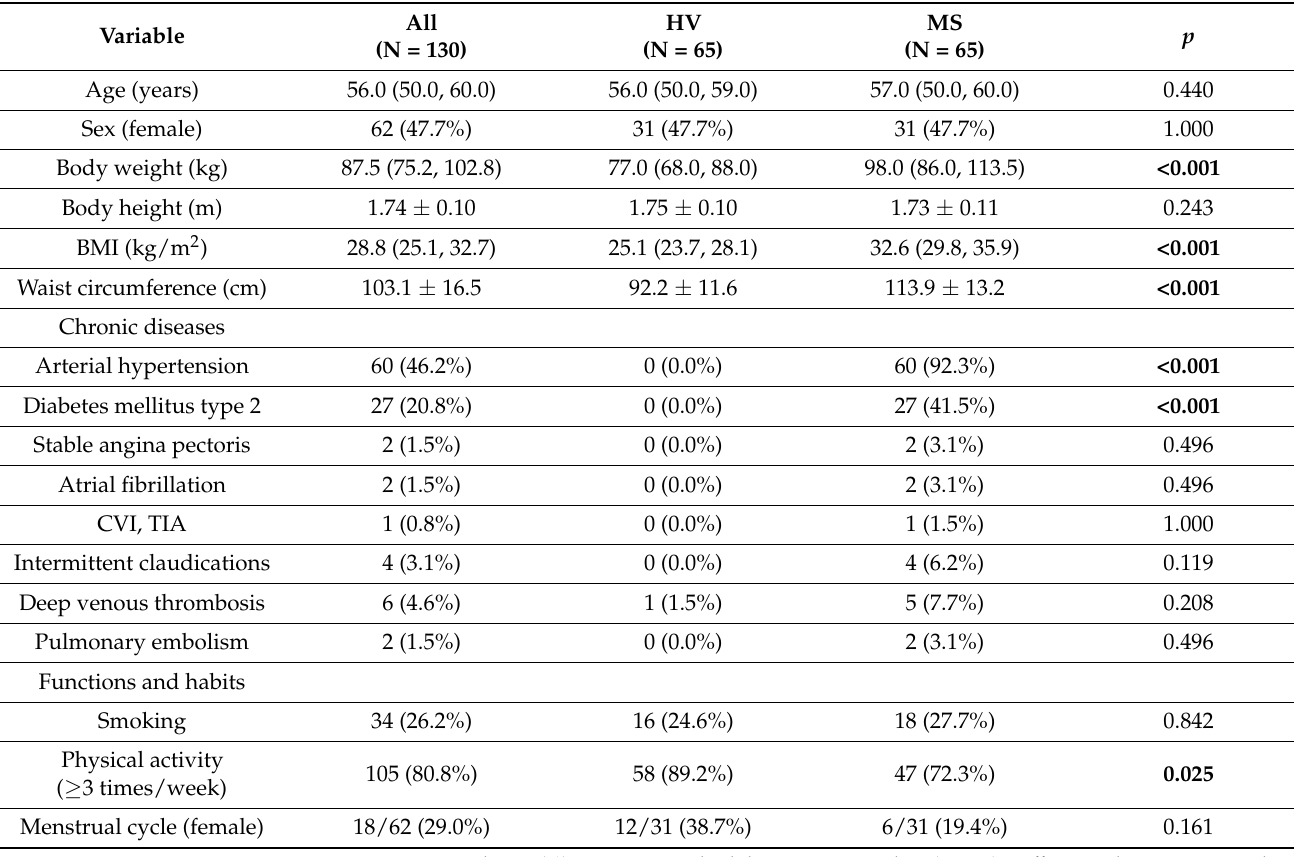
Table 1. Differences in demographic and clinical characteristics between HV and MS